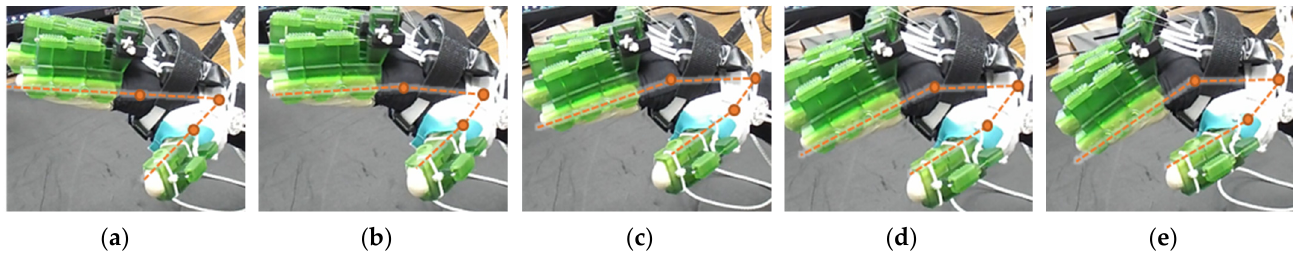
intermediate PIP joint positions; and ( e ) PIP joints are flexed, PIP joint angles: 80–82°. PIP joint positions; and ( e ) PIP joints are flexed, PIP joint angles: 80–82 ◦ .